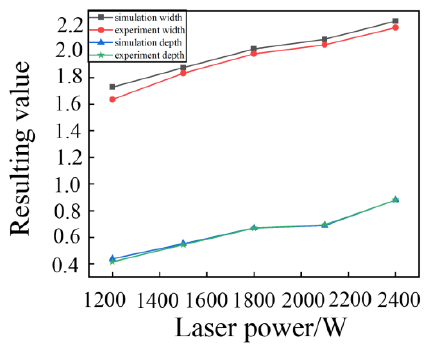
Figure 4. The variation rule of the laser power on the size of the molten pool.